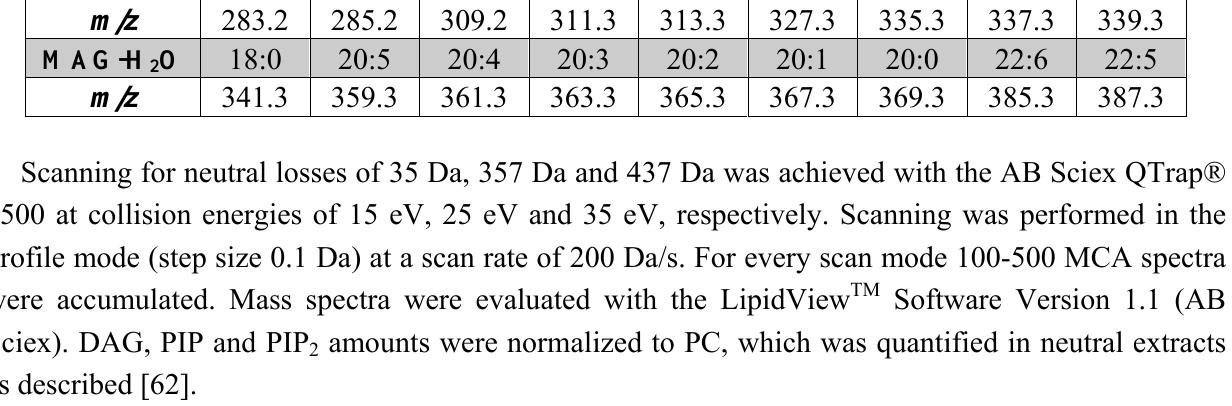
Table 3. DAG-specific MAG-H